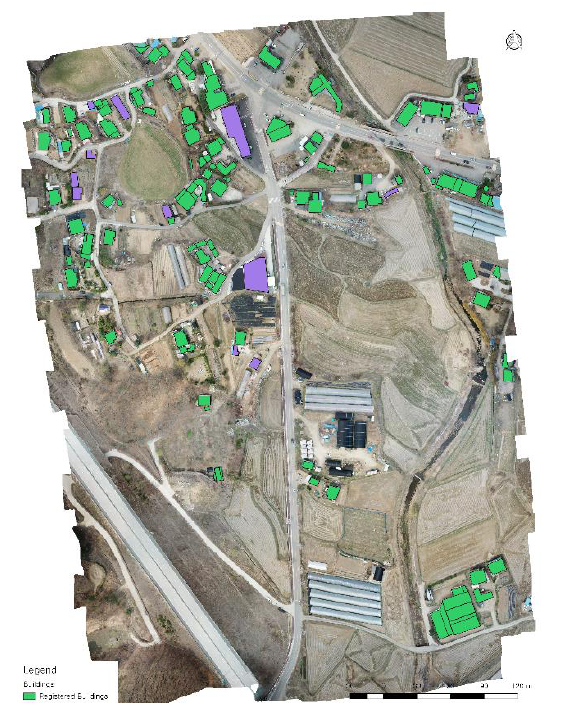
Figure 12. Registered buildings (green) and unregistered buildings (purple)